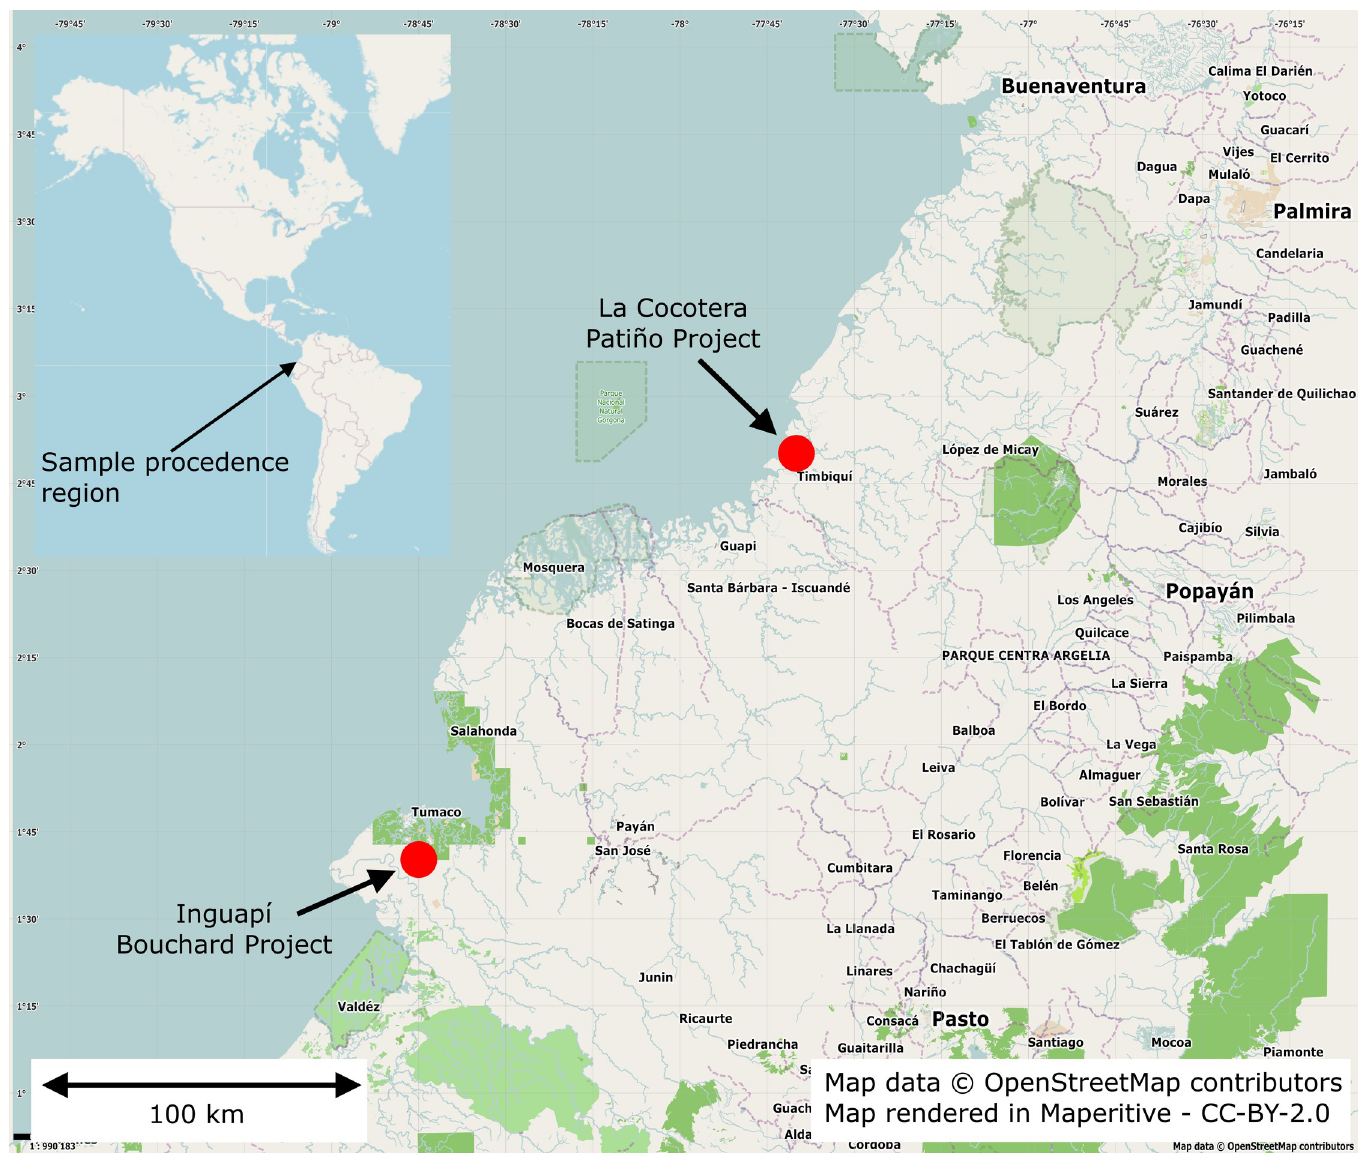
Fig 3. Map showing the archaeological sites where the ceramic fragments were obtained. The fragments from Inguapı´correspond to IN01 to IN05. The fragments from La Cocotera correspond to CO06 to CO09. Source: Map data © OpenStreetMap contributors and rendered in